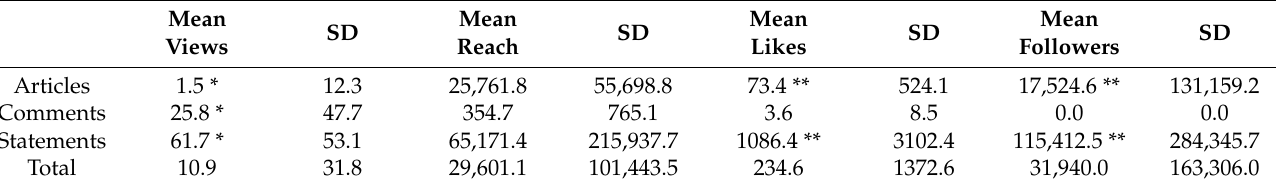
Figure 2. Mean DISCERN score for a single question.